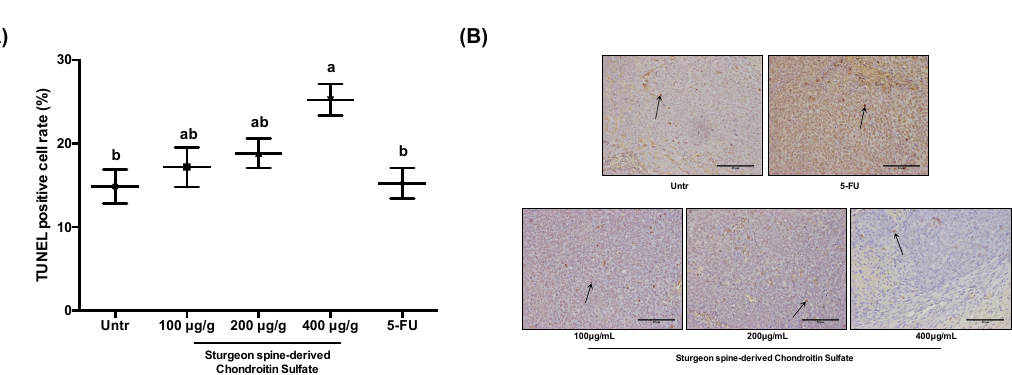
Figure 7. Effect of SCS on cell apoptosis in HCT-116 xenograft tumor mice model. Xenograft tumor tissues were collected after sacrifice and sectioned for TdT-mediated dUTP nick-end labeling (TUNEL) staining. ( A ) Percentage of TUNEL-positive cells, ( B ) Representation images of TUNEL staining. All results are expressed as mean ± SEM ( n = 10). Different superscript letters for each column indicate significant differences ( p < 0.05) as compared to every other group.